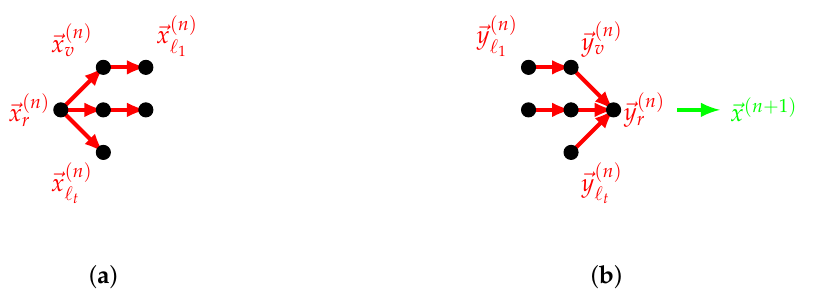
Figure 1. Illustration of updates in the distributed Kaczmarz algorithm with measurements indexed by nodes of the tree. ( a ) Updates disperse through nodes, ( b ) updates pool and pass to next